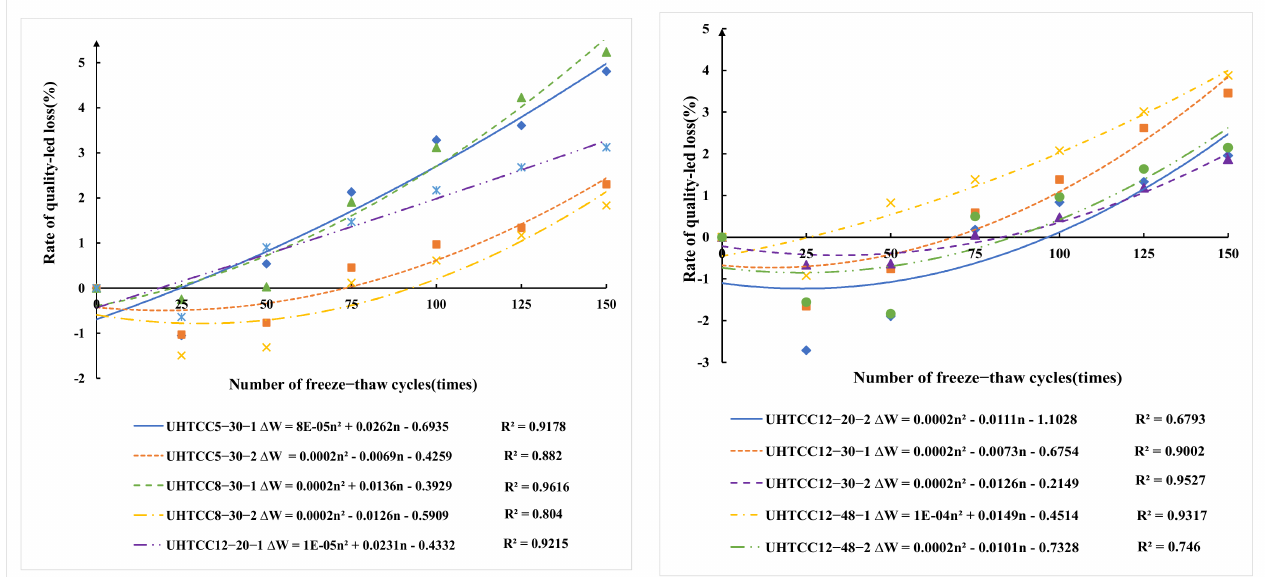
Figure 5. Mass damage under different number of freeze–thaw